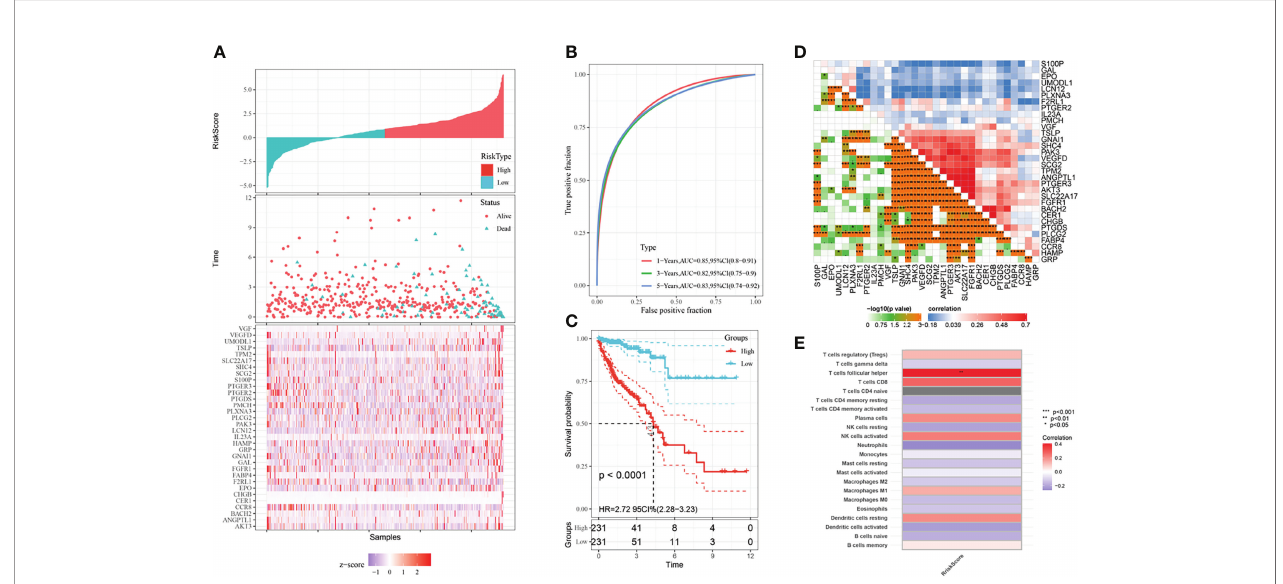
FIGURE 2 | Prognostic model and immune in fi ltration. (A) Risk distribution of CRC patients. (B) ROC curves of CRC patients. The blue line represents the 5-year survival rate; the green line represents the 3-year survival rate; the red line represents the 1-year survival rate. (C) KM plots of the prognostic model. The blue line represents the low-risk group, and the red line represents the high-risk group. (D) The close relationship between the prognostic genes screened through multivariate Cox regression. (E) The relationship between 22 kinds of immune cells and the risk score of the prognostic